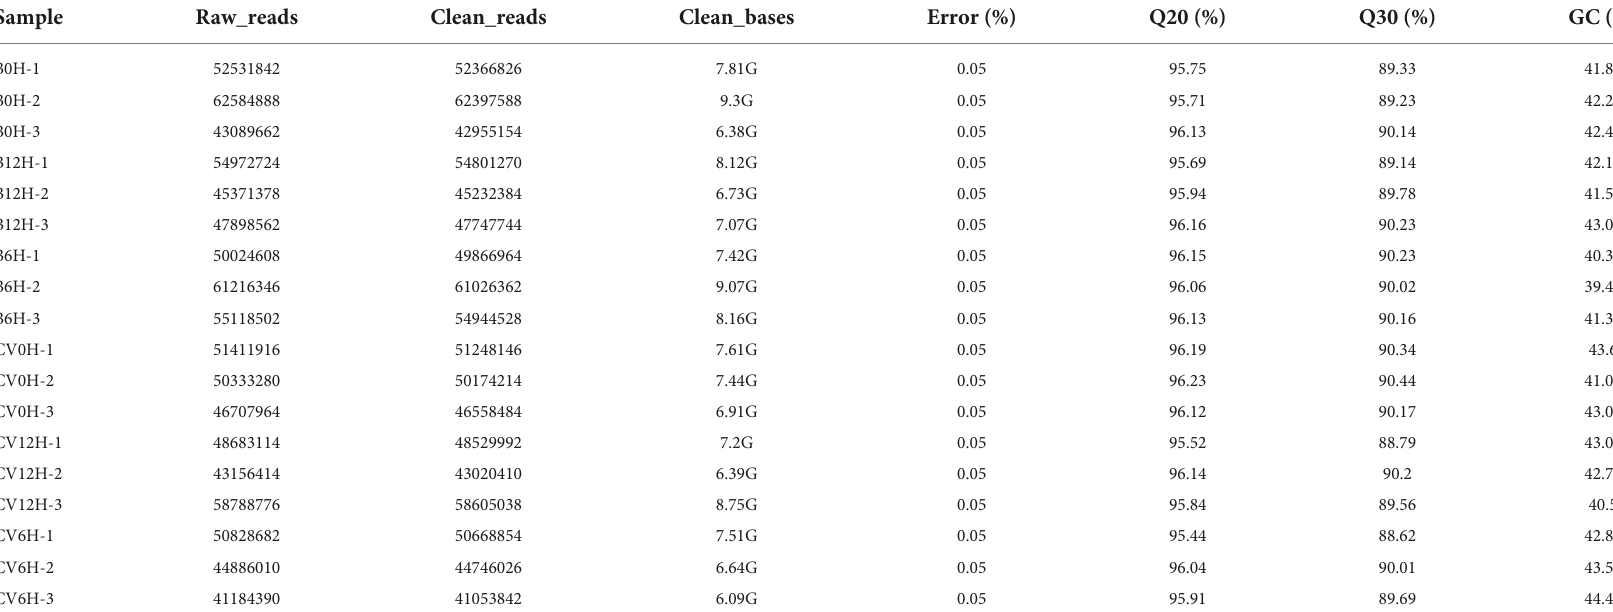
TABLE 1 Statistical summary of RNA-seq libraries from whiteflies (Asia II 7 and MEAM1 cryptic species) fed for 6 and 12 h on CLCuMuV-infected or uninfected (0 h) cotton plants.